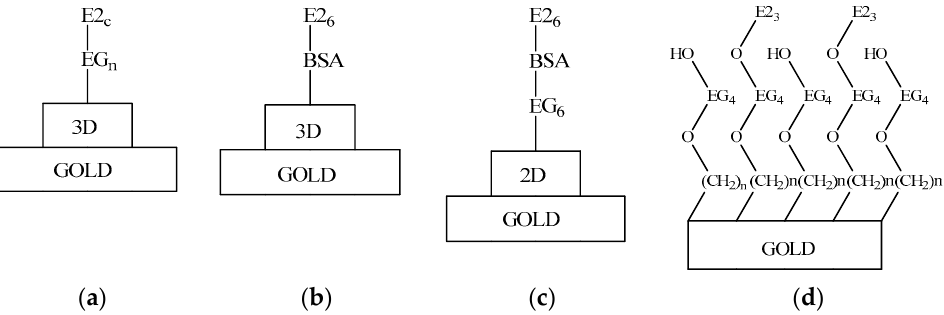
Figure 2. A sensitive layer configuration. EG n —ethylene glycole moiety with n its units, BSA—bovine serum albumin, E2 C —estradiol conjugated to the surface in the c position of the steroid molecule.